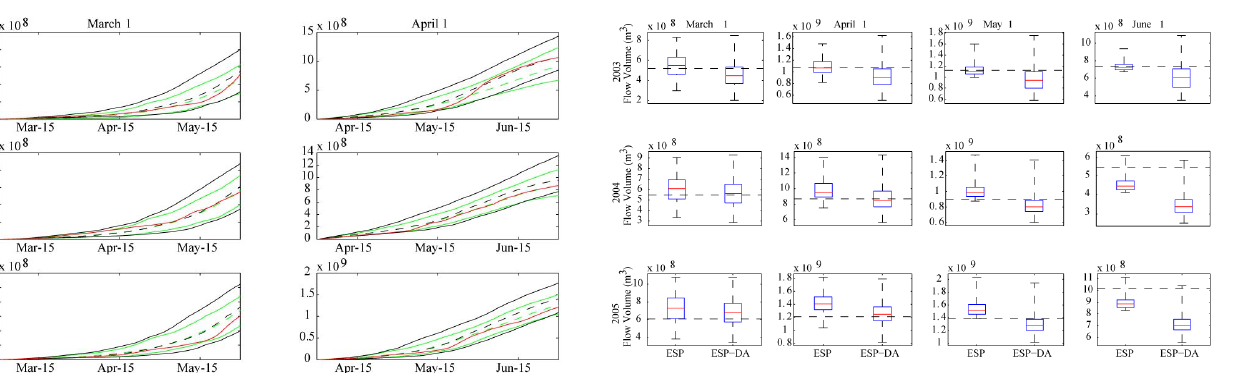
Fig. 6. Cumulative daily volumetric flow plots summed across all 15 basins. This figure shows the 95% predective bounds of the cu- mulative runoff volume from ESP (black lines) and ESP-DA (green lines). The expected value of each is a dashed line and the cumula- tive observed runoff volume is the red line.